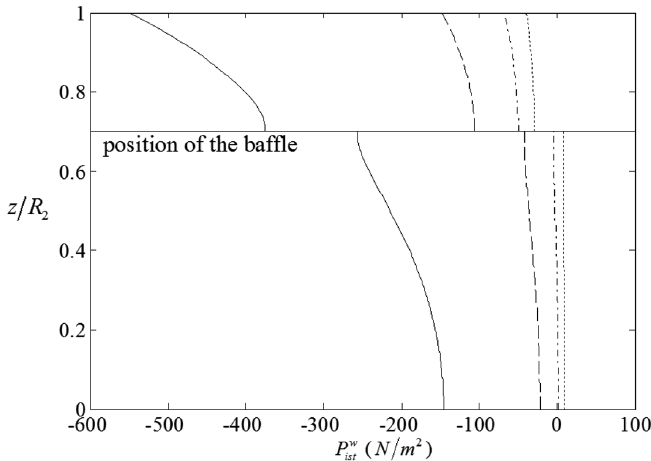
Fig. 6. The wall pressure distribution P w ist at θ = 0, ¯ ωt = π /2 for h 1 / R 2 = 0.3, and four different R 1 / R 2 (